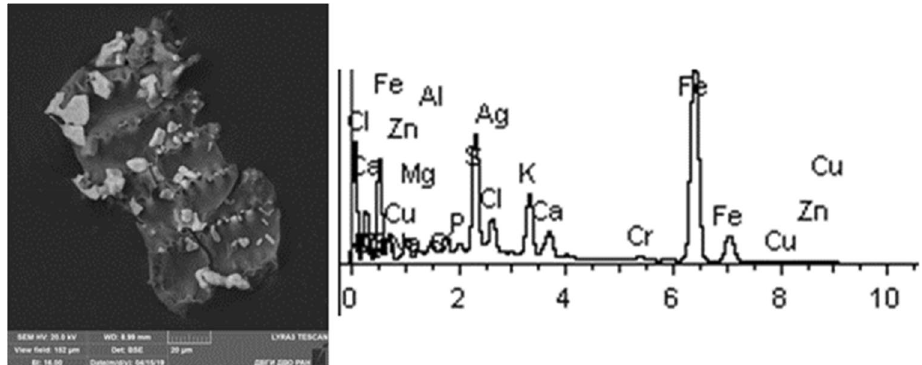
Figure 18. Silvering. Particles morphology. Scanning electronic microscopy. 1) Measuring interval 20